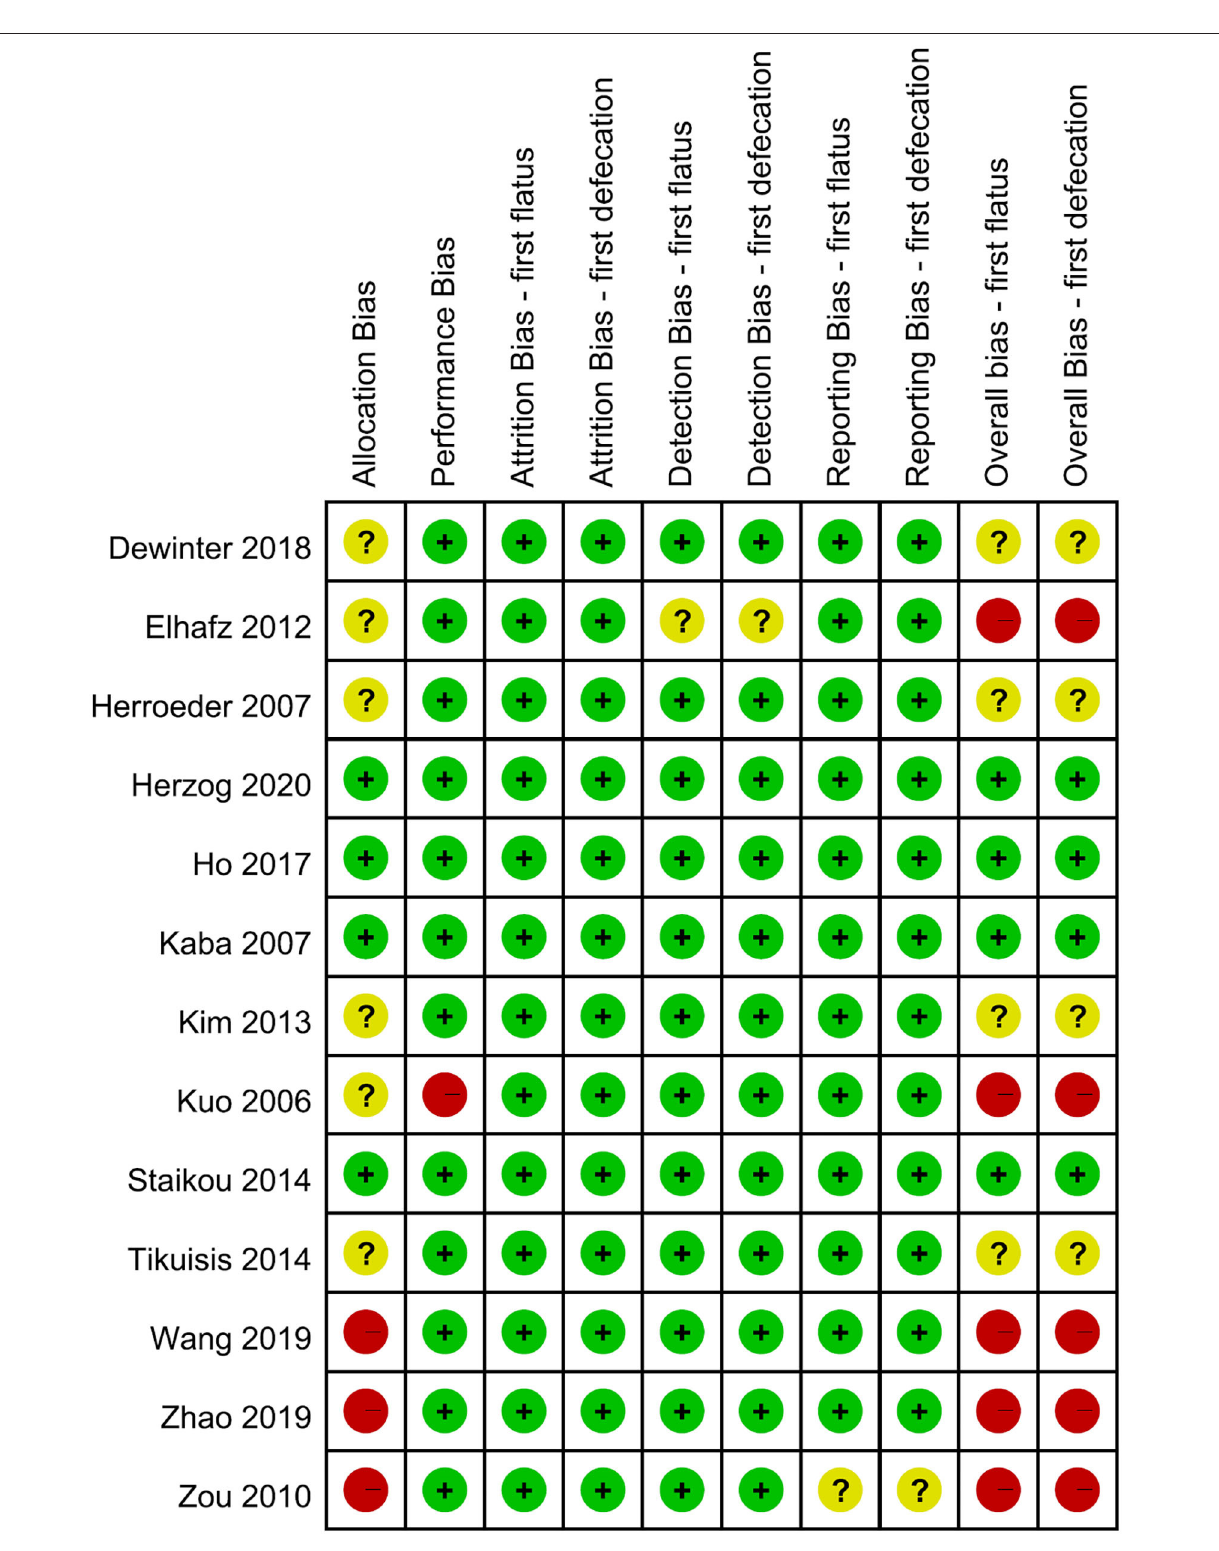
Frontiers in Medicine |